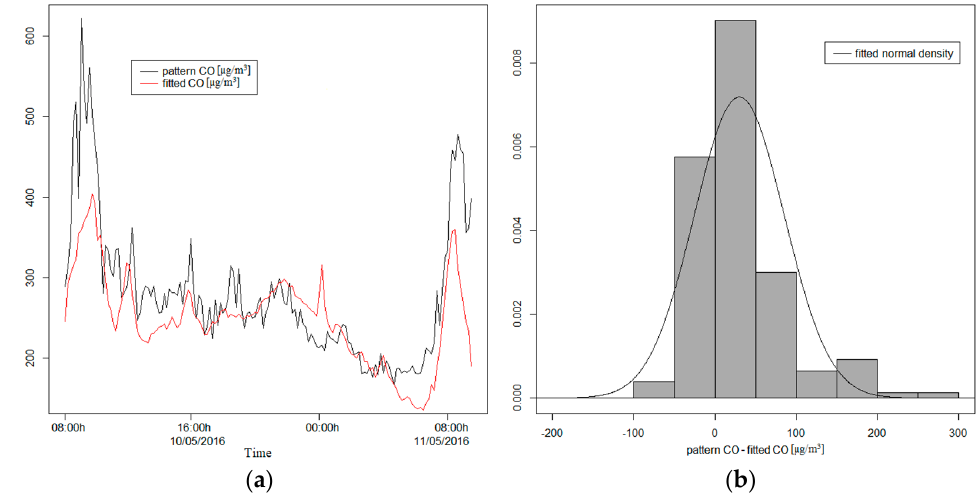
Figure A4. Both graphs with the test dataset. ( a ) The fitted values by the model and the pattern values for carbon monoxide; ( b ) the histogram of the net prediction errors of the model.